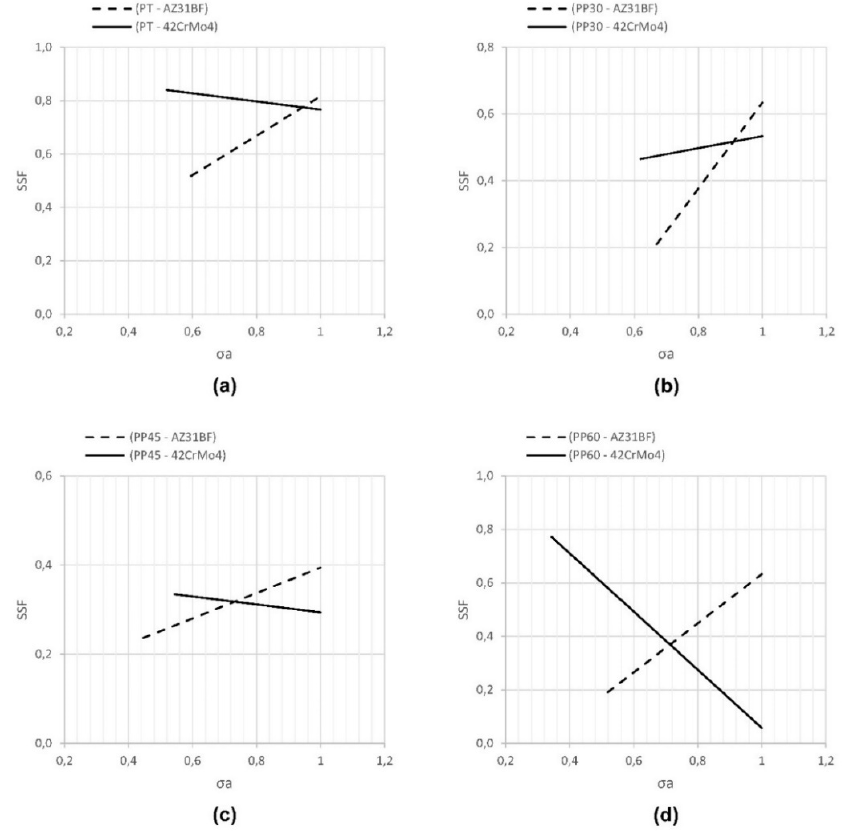
Figure 8. ssf experimental results for AZ31B-F and 42CrMo4. ( a ) Case 1—PT pure tension, ( b ) Case 3—PP30, ( c ) Case 4—PP45, and ( d ) Case 5—PP60.